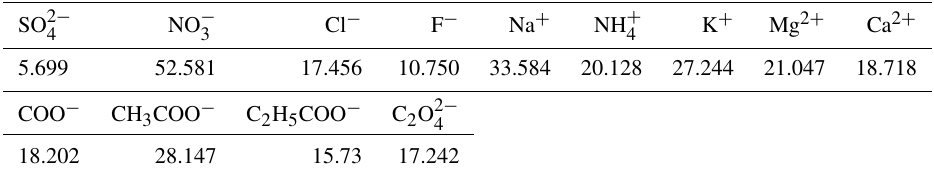
Table 1. DLs (ppb) of inorganic ions and water-soluble organic acids determined in this study.